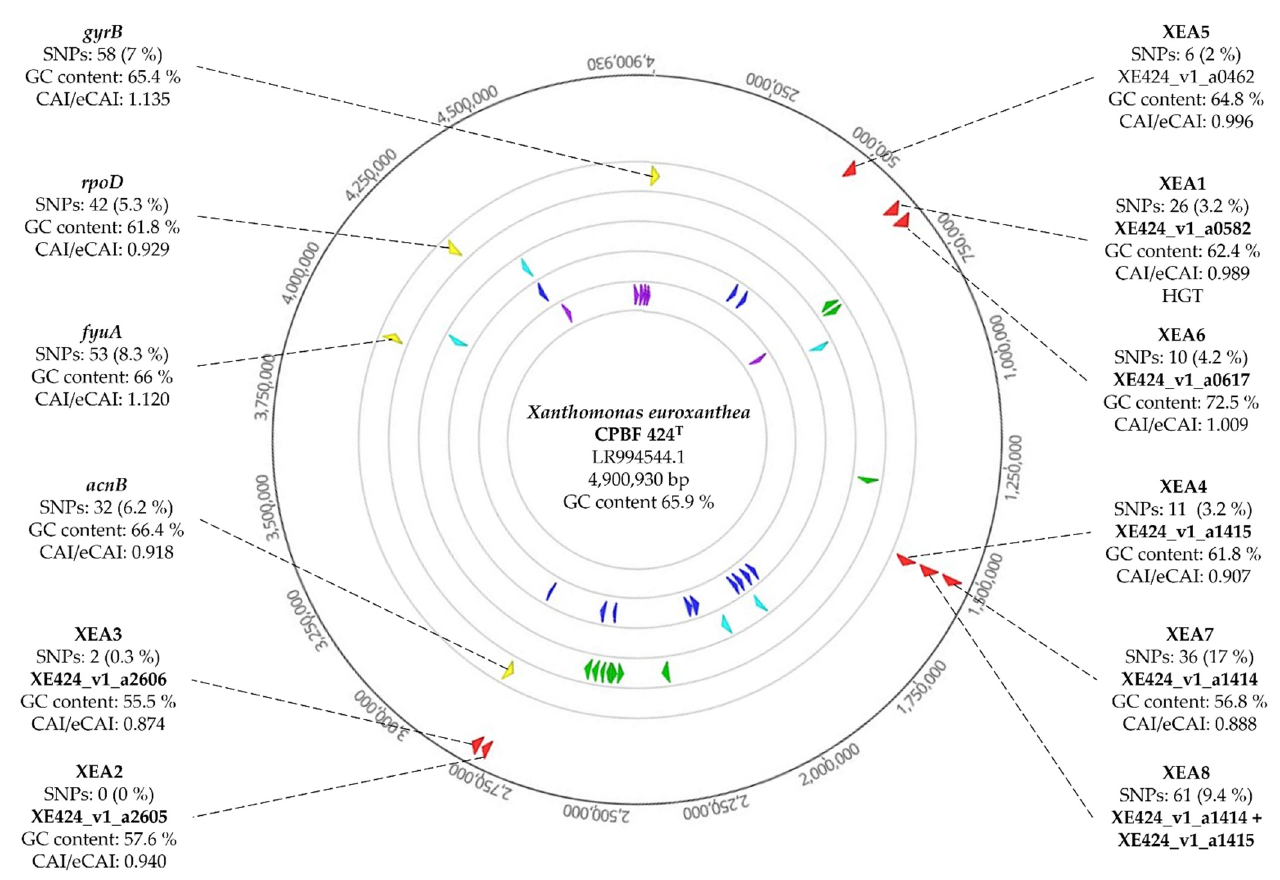
Figure 3. Circular map of Xanthomonas euroxanthea strain CPBF 424 T chromosome. Outside to inner circles are showing genome coordinates (bp); X. euroxanthea -specific DNA markers XEA1-XEA8 (red); housekeeping genes gyrB , rpoD , fyuA and acnB (yellow); transposases (green); recombinases (light blue); integrases (dark blue) and phage-related ORFs (purple). For each XEA DNA marker and housekeeping gene the number of SNPs (calculated based on 11 genomes of X. euroxanthea ), GC content and CAI/eCAI values are shown.